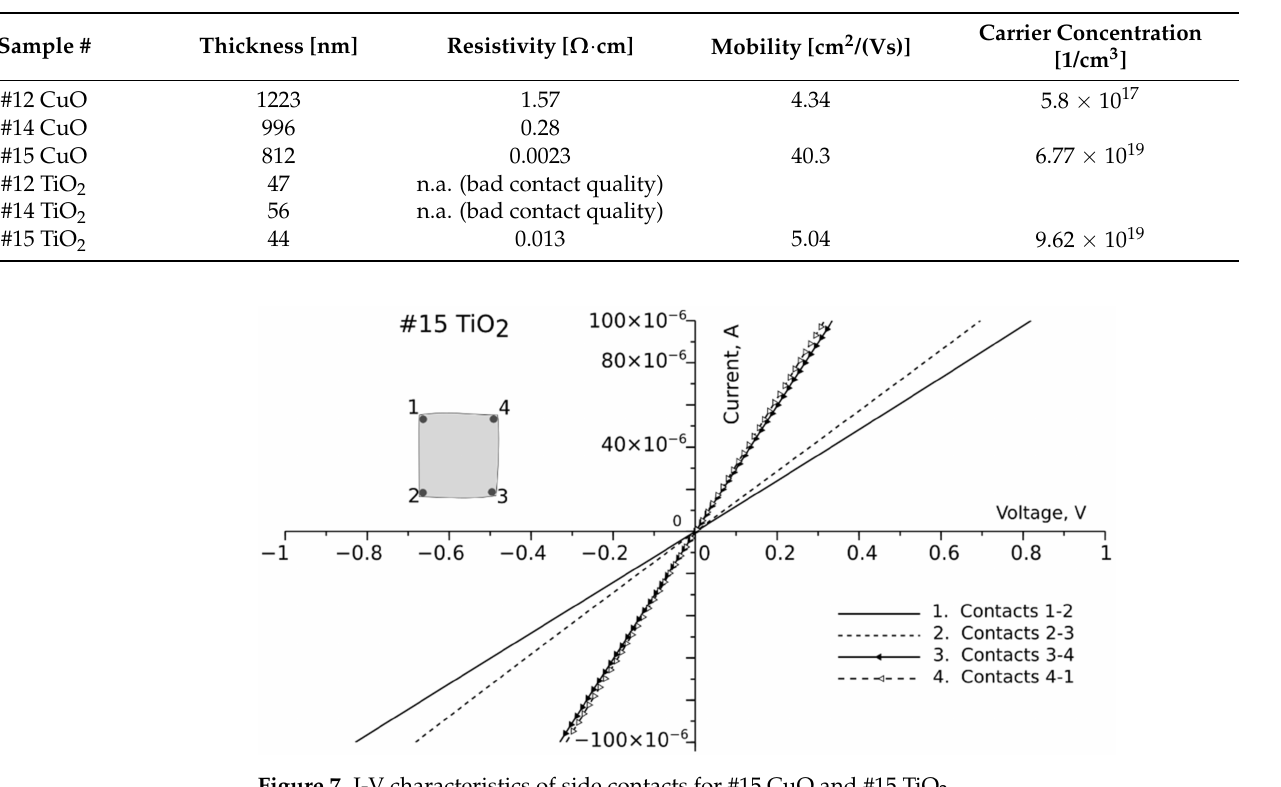
Figure 7. I-V characteristics of side contacts for #15 CuO and #15 TiO 2